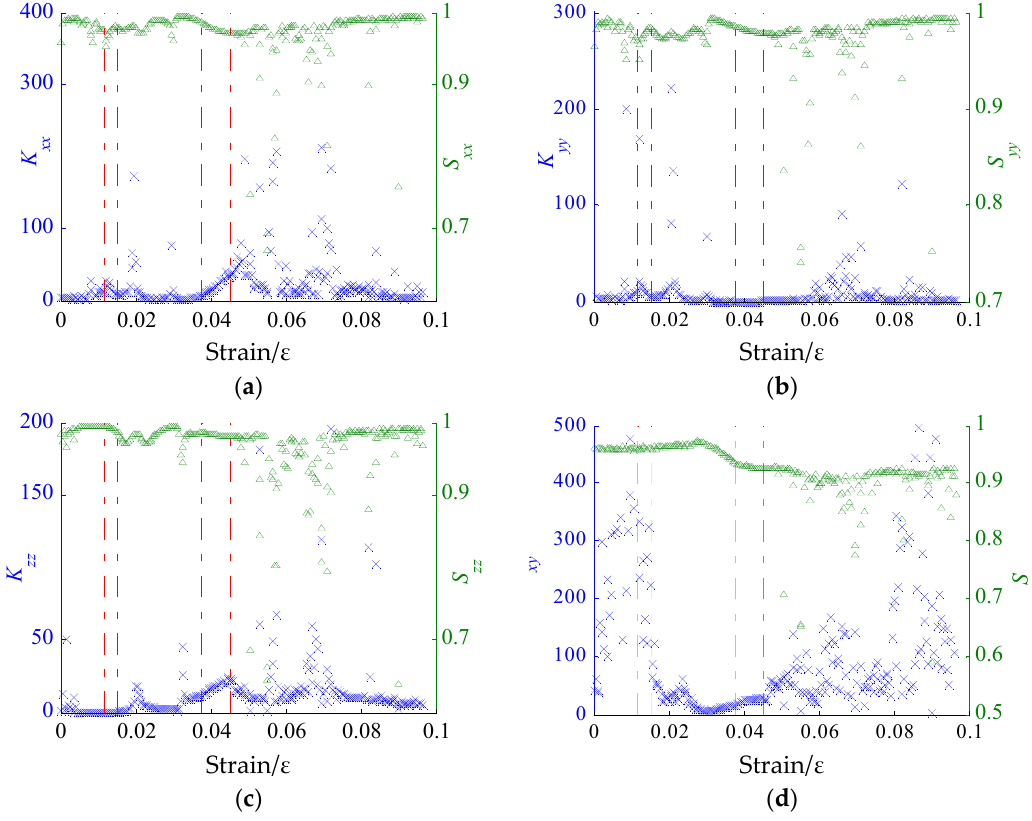
Figure 7. Revolution of the stress concentration factor and entropy ( a ) K xx and S xx ; ( b ) K yy and S yy ; ( c ) K zz and S zz ; and ( d ) K xy and S xy .